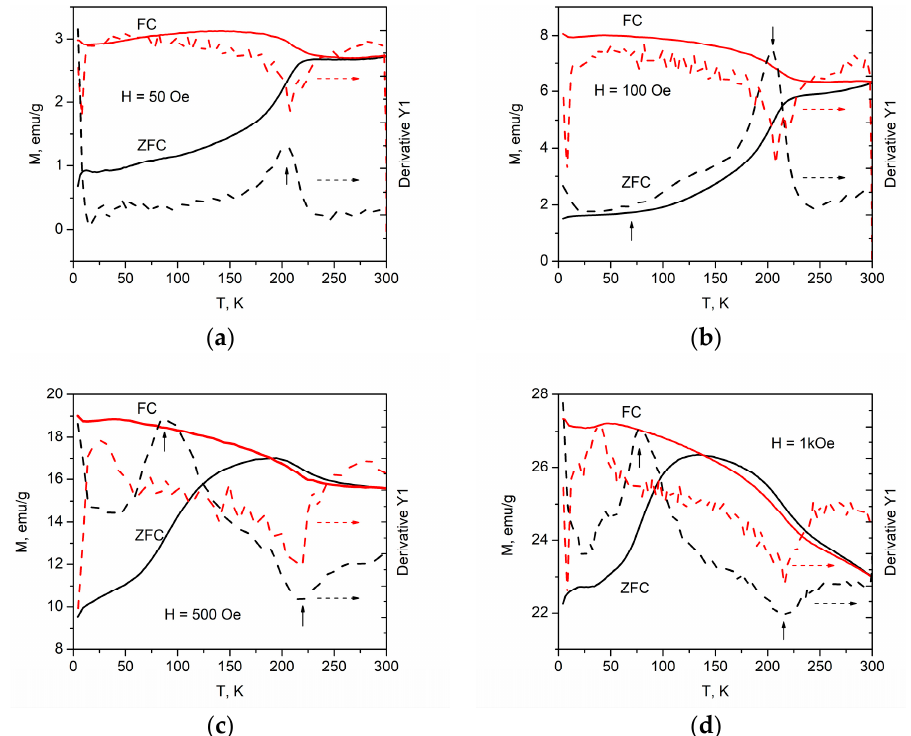
Figure 4. Temperature dependence of zero-field-cooled (ZFC) and field-cooled (FC) magnetization at a magnetic field of ( a ) 50 Oe, ( b ) 100 Oe, ( c ) 500 Oe and ( d ) 1 kOe.